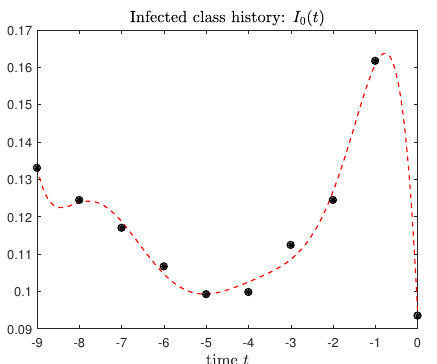
Figure 2. Best − fit polynomial for the nodal values of infected density in the lag period. Red dashed line: plot of history function I 0 ( t ) in the whole sample period [ − 9,0 ] . Black bullets: nodal values which are measured for infected density, they are obtained by relating the entries of the vector v I = ( 232, 217, 204, 186, 173, 174, 196, 217, 282, 163 ) to the initial number of companies N 0 = 1744 operating at t =